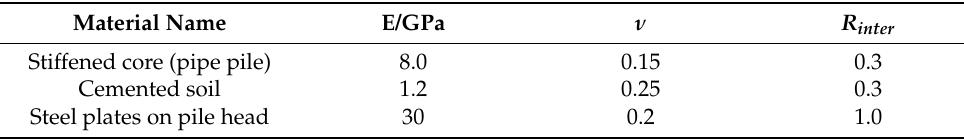
Table 4. Parameters of the tested composite pipe pile. Figure 4. 3D finite element model.